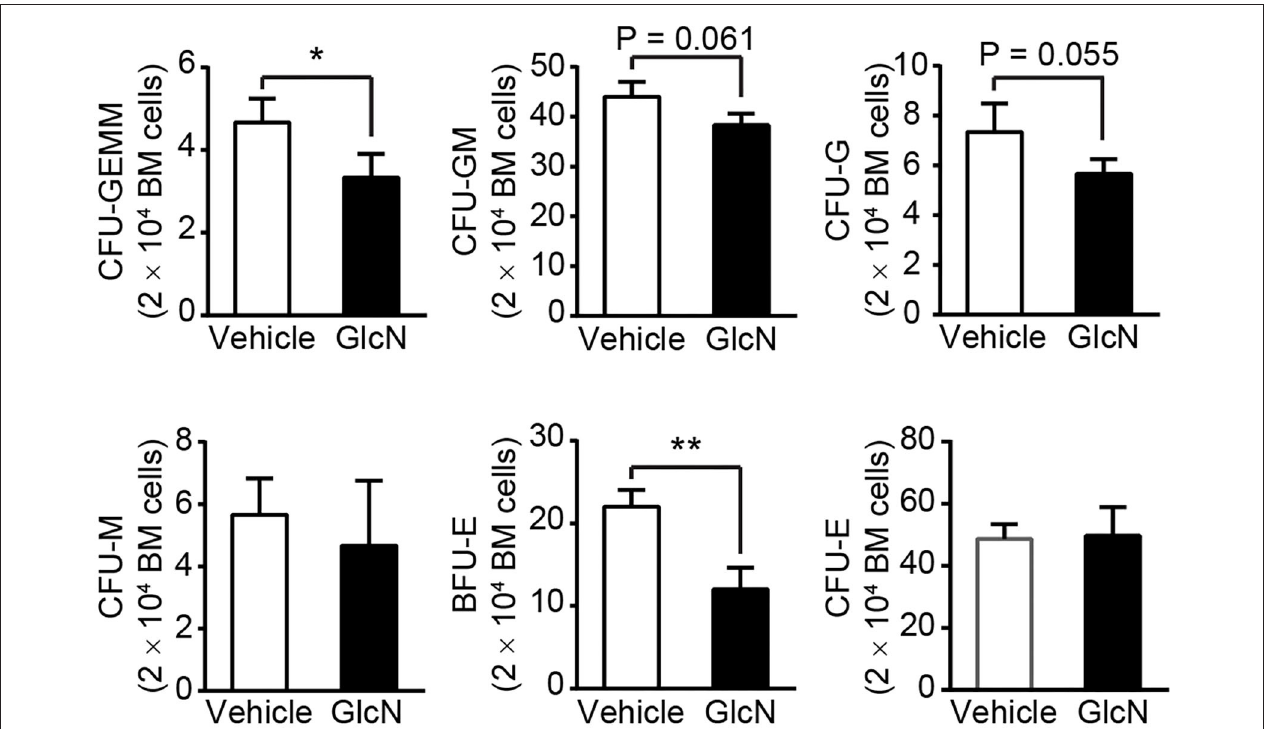
FIGURE 6 | GlcN treatment weakens hematopoietic stem and progenitor cell differentiation. BM cells from i.p.-injected mice were extracted and directly cultured in methylcellulose-based medium M3434. Colonies were counted after 10 days of culture. Quantification of CFU-GEMM, CFU-GM, CFU-G, CFU-M, BFU-E and CFU-E. Quantified results are presented as the mean ± standard deviation. * P < 0.05; ** P <